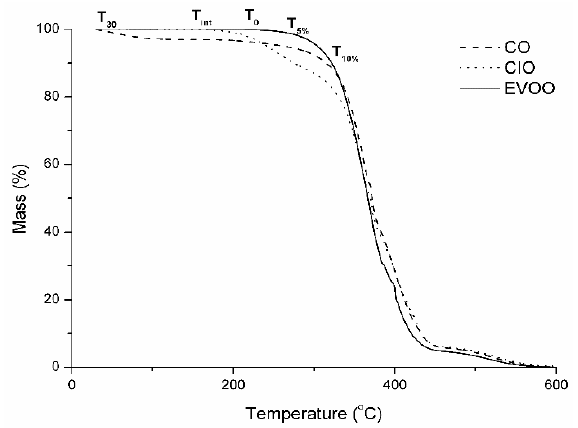
Figure 3. TG curve comparisons for the three different oils showing the selected temperatures corresponding to the degradation of Colliguaya integerrima (CIO), Cynara cardunculus (CO), and extra-virgin olive (EVOO) oils.